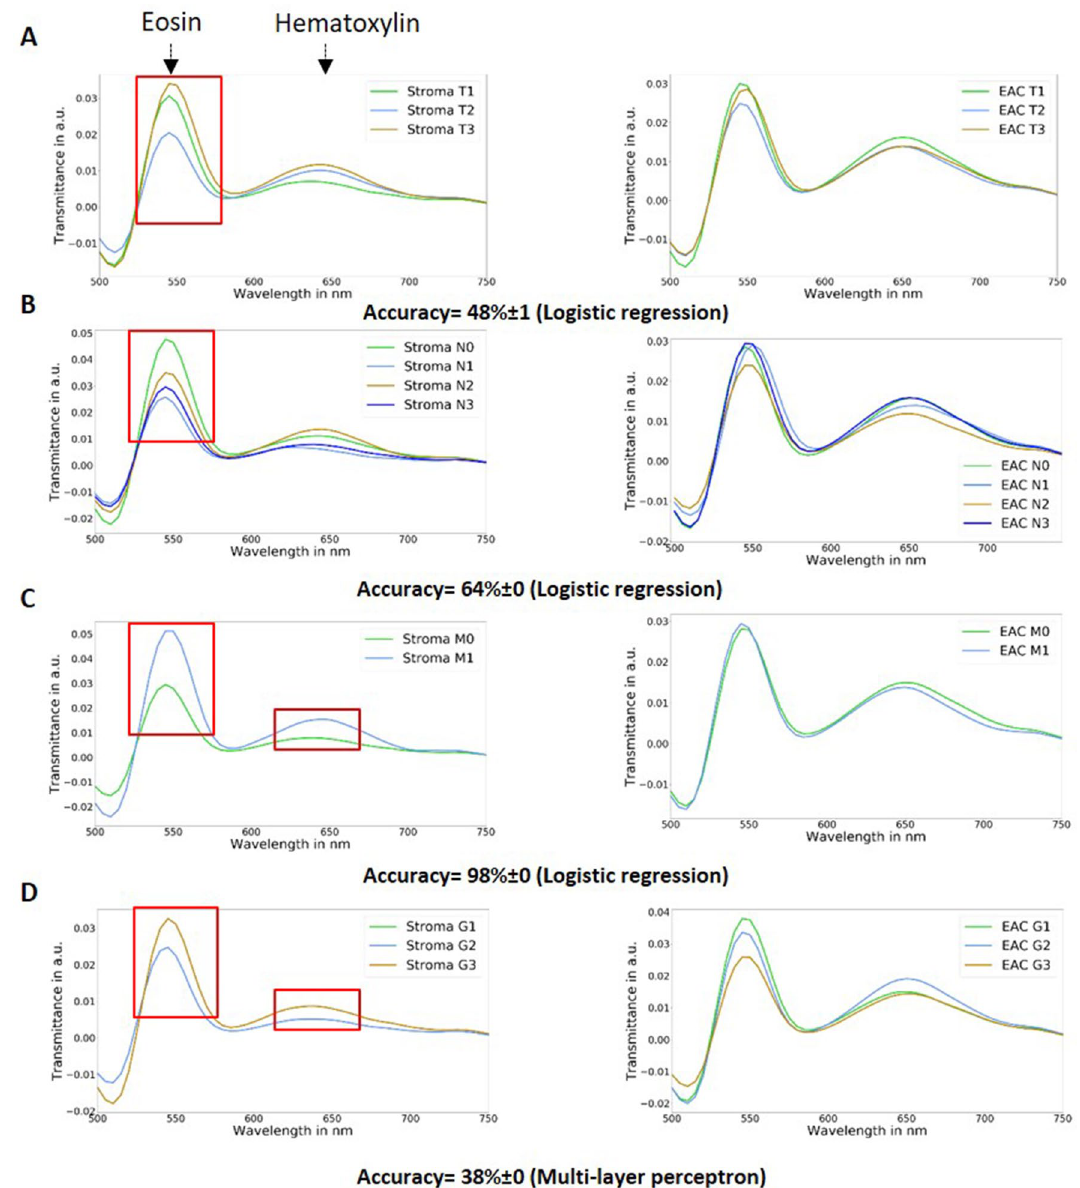
Figure 6. Mean transmittance of the TNM-classification ( A – C ) and grading ( D ) in stroma (first column) and EAC cells (second column). The achieved accuracy and the applied classification algorithm is shown under the spectra. The red rectangle shows the areas of high differences of the spectra. ( A ) The mean transmittance of stroma depicts high difference in the range from 525 nm to 575 nm in case of T-category only. ( B ) The mean transmittance of stroma reveals high variance in the range from 525 nm to 575 nm in case of the N-category. ( C ) The mean transmittance of stroma showed high variance in the range from 525 nm to 575 nm and in the range from 625 nm to 675 nm in case of the N-category. ( D ) The mean transmittance of stroma demonstrated high variance in the range from 525 nm to 575 nm and in the range from 625 nm to 675 nm in case of the N-category. The classification results for the gradings was less than 48%